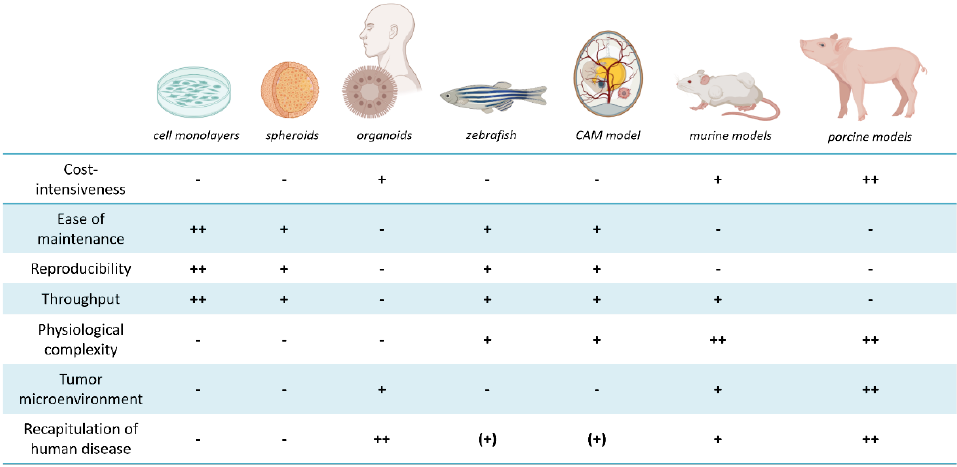
Figure 2. Key aspects of the described in vitro and in vivo models are summarized. The models were rated relative to each other in different categories. For example, costs (initial outlay and mainte- nance costs), as well as care-intensiveness, may play a critical role in the selection of the model. Animal models are generally more laborious and demanding in terms of equipment and care than in vitro models. However, the generation and maintenance of human organoid cultures are rela- tively expensive as they require specialized reagents and growth factors. The reproducibility of results highly depends on the grade of standardization of an assay or experiment. Cell experiments using 2D cultures can be performed easily in a standardized manner, while experiments based on human material or living organisms usually have higher variability. At the same time, it is hardly feasible to handle large cohorts or sample sizes when experimenting with large animals or very sophisticated models. The translational value of a model not only depends on the physiological complexity or used species but also if the chosen model organism to be engrafted is immunocom- promised or immunocompetent, enabling to study the tumor microenvironment. In the context of personalized medicine, patient-derived organoid cultures or PDX animal models recapitulate hu- man disease more accurately than immortalized cell lines or murine xenograft models of those. The figure was partly created with BioRender.com. 5. Conclusions A successful establishment and translation of new biomarkers from a preclinical setting towards the clinical application strongly depends on the significance of the target, and the performance and explanatory power of the model in use. We are all aware of the fact that the time for developing and establishing new tracers from bench to bed is far too long. Established models and cell lines, used in the imaging community and validated for our needs for decades, provide limited insights into human disease. Experimental nu- clear medicine needs to learn from and to team up with different fields of tumor biology, molecular pathology and oncology. In a clinical setting, personalized diagnosis of tumor diseases requires the ability and readiness to converge with different fields and disciplines. This need was already recog- nized by others and Sorace et al. proposed an idealized workflow model for radiology – pathology integration [98]. Not only nuclear medicine but also pathology itself can ben- efit from molecular information obtained by imaging and a need for molecular imag- ing-based pathology was identified as well [41]. In the publication “Convergence—The Future of Health Report 2016”, the authors state literally that “Convergence comes as a result of the sharing of methods and ideas by chemists, physicists, computer scientists, engineers, mathematicians, and life scientists across multiple fields and industries. It is the integration of insights and approaches from historically distinct scientific and technological disciplines ” (5) . With this in mind, we wanted to give an overview of different methods and approaches in the fields of exper- imental nuclear medicine and molecular pathology to create a common understanding and facilitate future collaborations. We expect that functionally and biologically relevant